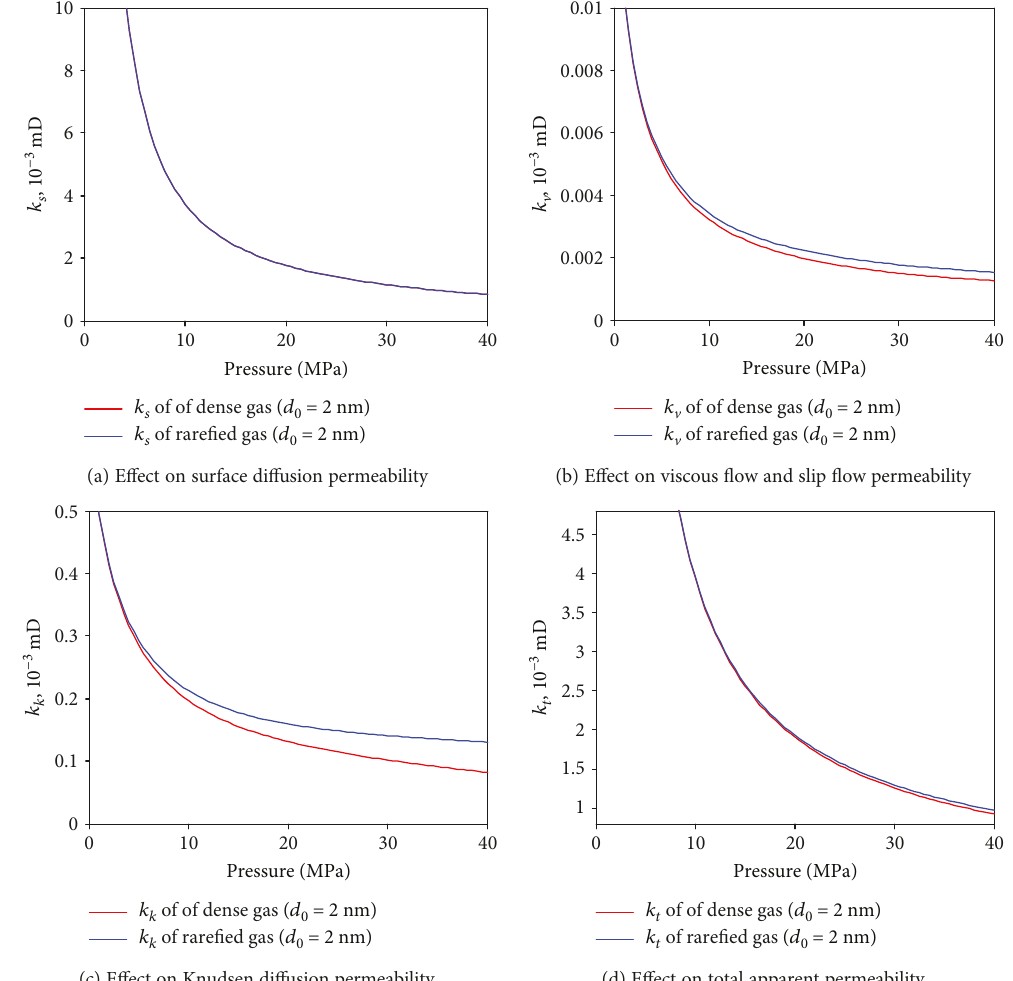
Figure 16: The e ff ect of gas density on apparent permeability of shale (pore diameter = 2nm ).